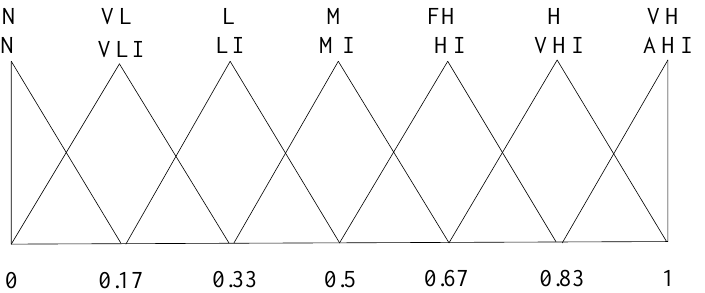
Figure 3. Linguistic terms of S 1 and S 2 , and its fuzzy numbers. Table 3. Description of the criteria considered. Criteria Description Information Type The higher the rainfall, the Rainfall (mm) ( C 1 ) more easily a landslide occurs The lower the coverage rate of Coverage rate of the forest (%) the forest, the more easily a ( C ) 2 landslide occurs The higher the saturated Saturated water content of soil water content of the soil, the (%) ( C 3 ) more easily a landslide occurs Slope ( ◦ ) ( C 4 )